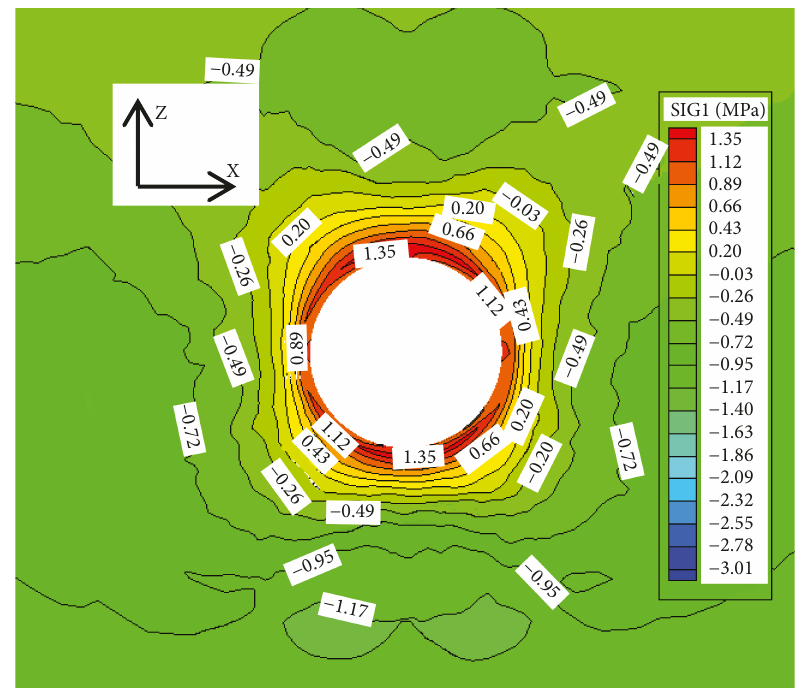
Figure 25: Major principal stress on section